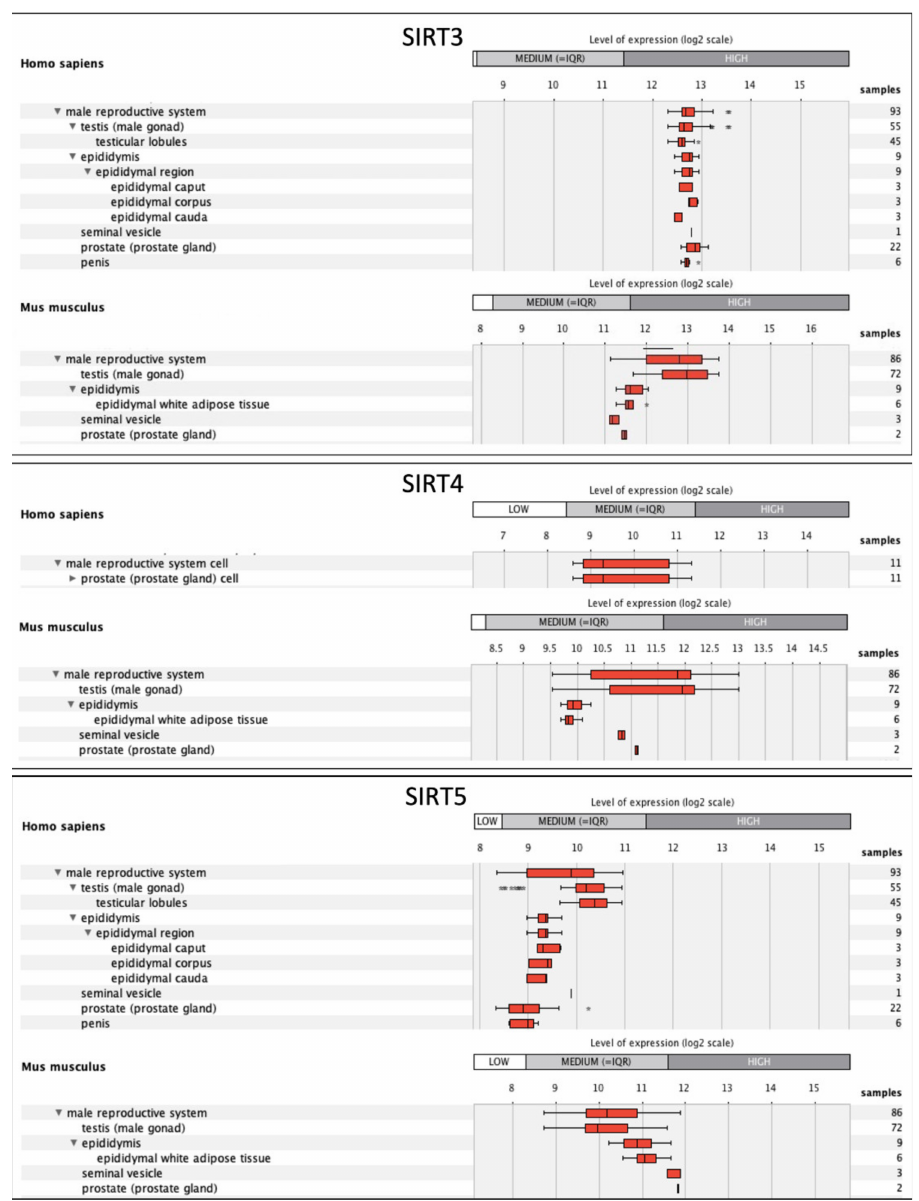
Figure 5. In silico analysis of SIRT3, SIRT4 and SIRT5 gene expression in the male reproductive system using GENEVESTIGATOR software [137] (https://genevestigator.com/gv/index.jsp, access date 28 April 2021). See text for